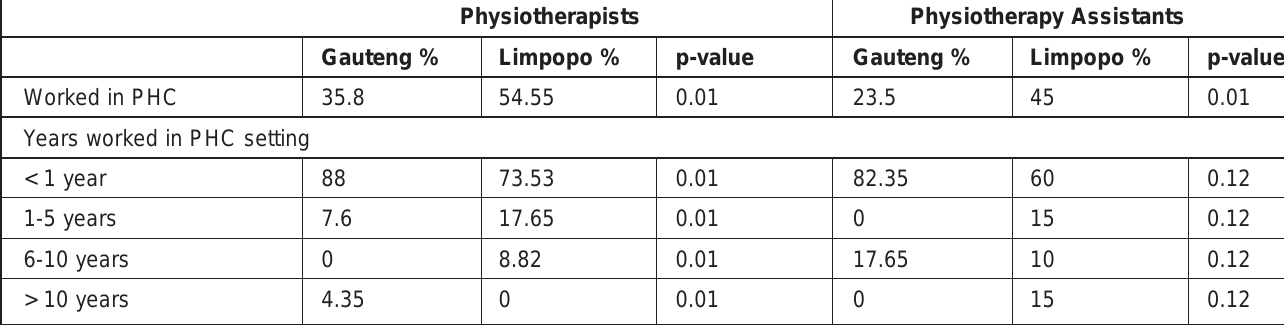
Physiotherapists